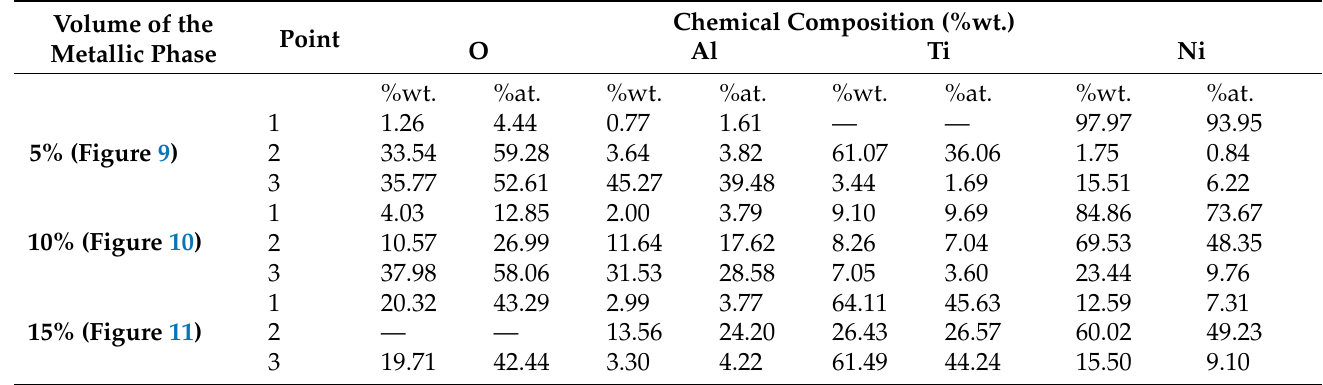
Table 4. Chemical composition of characteristic areas of the composites. Measurement areas are shown in Figures